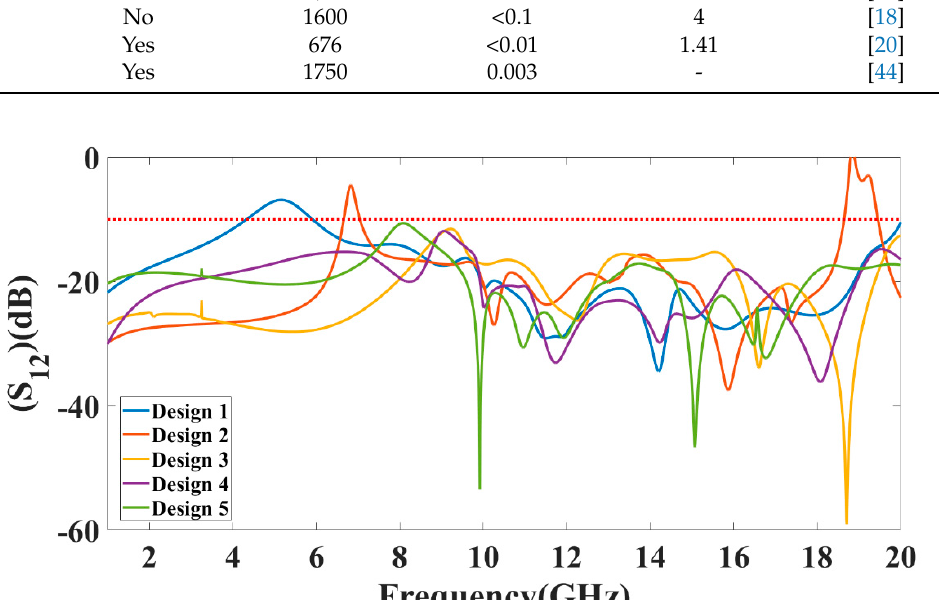
Figure 14. Comparative plot of measured cross-port reflection values (S 12 ) for the different antenna designs. Table 5. Comparative analysis of the proposed MIMO antenna with previously published results in terms of different antenna parameters.